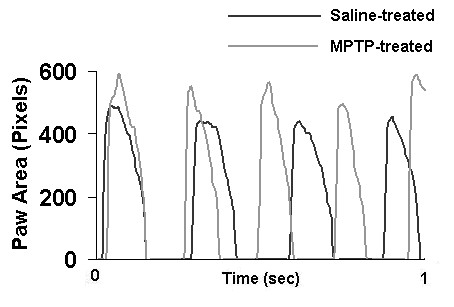
Gait signals in a MPTP-treated mouse. Gait signal of the right hind limb of a MPTP-treated mouse superimposed over the gait signal of the right hind limb of a saline-treated mouse. Stride frequency was higher in MPTP-treated mice compared to saline treated mice. Stance duration and swing duration were shorter in MPTP-treated mice compared to saline-treated mice.